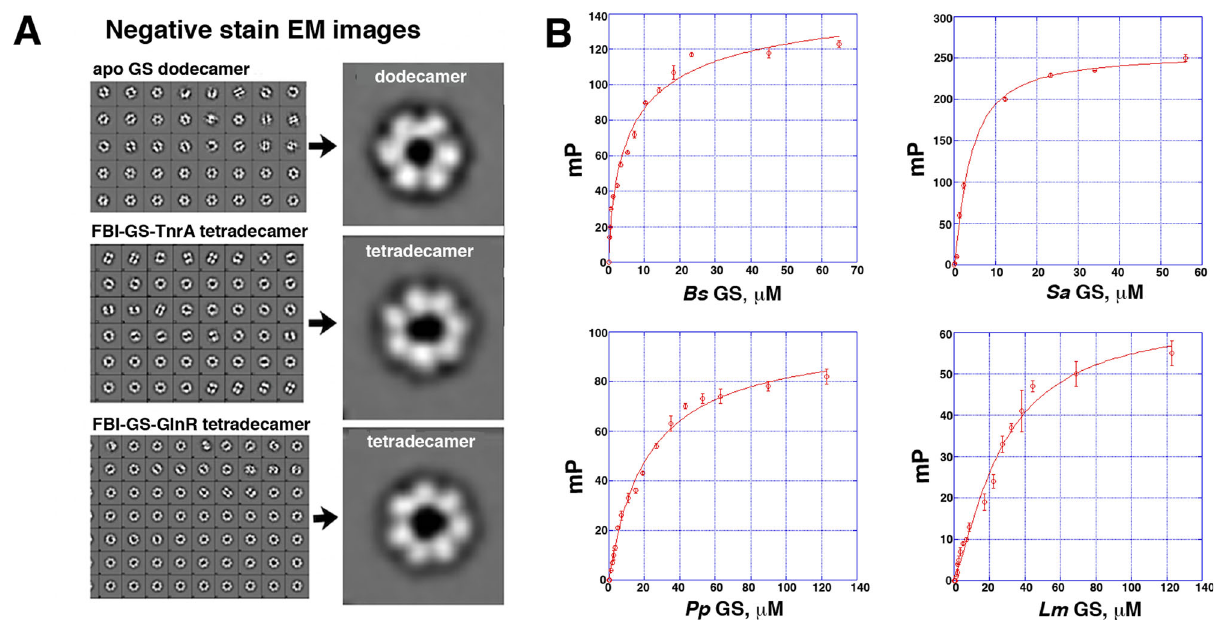
Fig. 1 Bs GS forms tetradecamers in the presence of TnrA and GlnR. A 2D class averages of negative stain EM images of apo Bs Gs, Bs FBI-GS-TnrA, and Bs FBI-GS-GlnR complexes. Right shows a close-up of the top views revealing that apo Bs GS is a dodecamer, while Bs FBI-GS-TnrA and Bs FBI-GS-GlnR are tetradecamers. B Fluorescence polarization (FP) based assays analyzing Bs FBI-GS, Sa FBI-GS, Pp FBI-GS, and Lm FBI-GS binding to their corresponding fl uoresceinated GlnR C-tails with K μ M, 7.2 ± 0.3 μ M, 18.7 ± 3.3 μ M, and 27.2 ± 3.4 μ M, respectively. The curves are representative curves d s of 4.2 ± 0.3 from three technical repeats. The error bars represent SD. Data were presented as mean values ± SD. The source data are provided in the Source Data fi